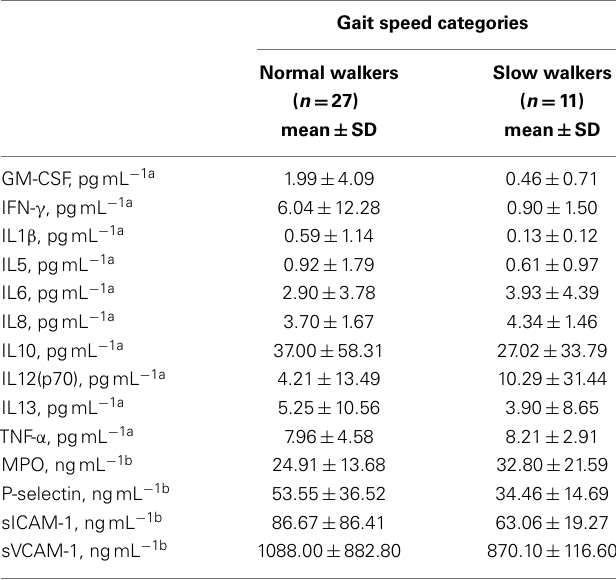
Table 2 | Serum or plasma concentration of inflammatory biomarkers according to gait speed categories .